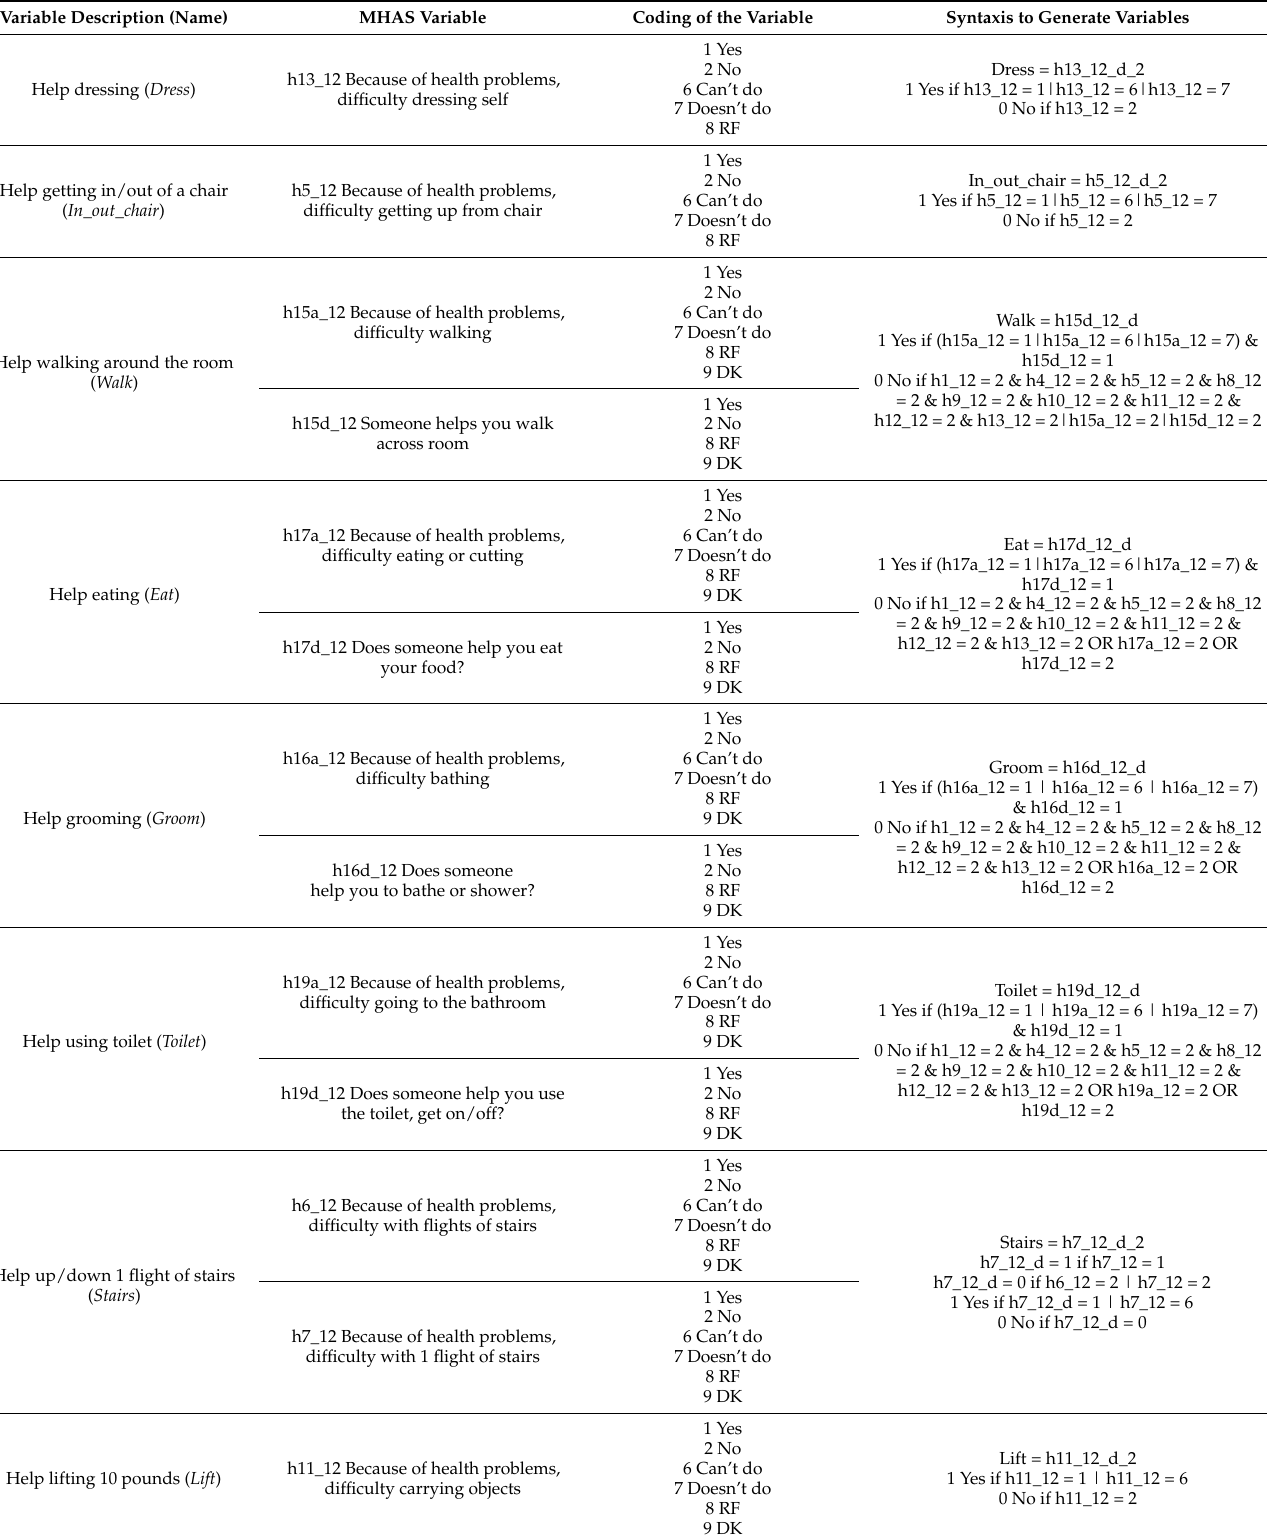
Table A1. Syntaxis to create each variable used in this